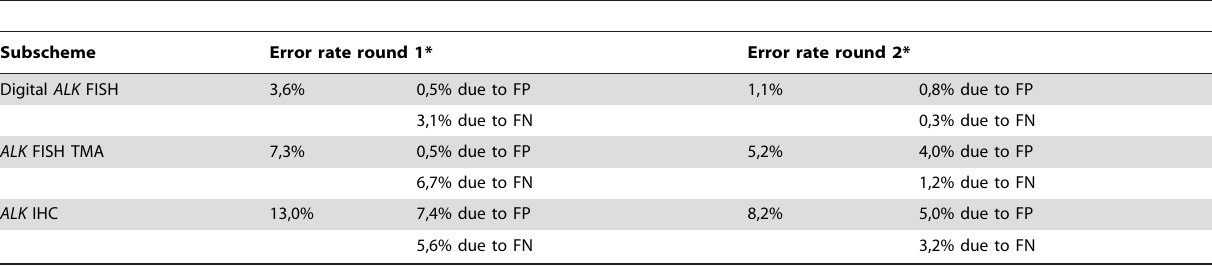
Table 6. Scheme error rates per subscheme for both pilot rounds.